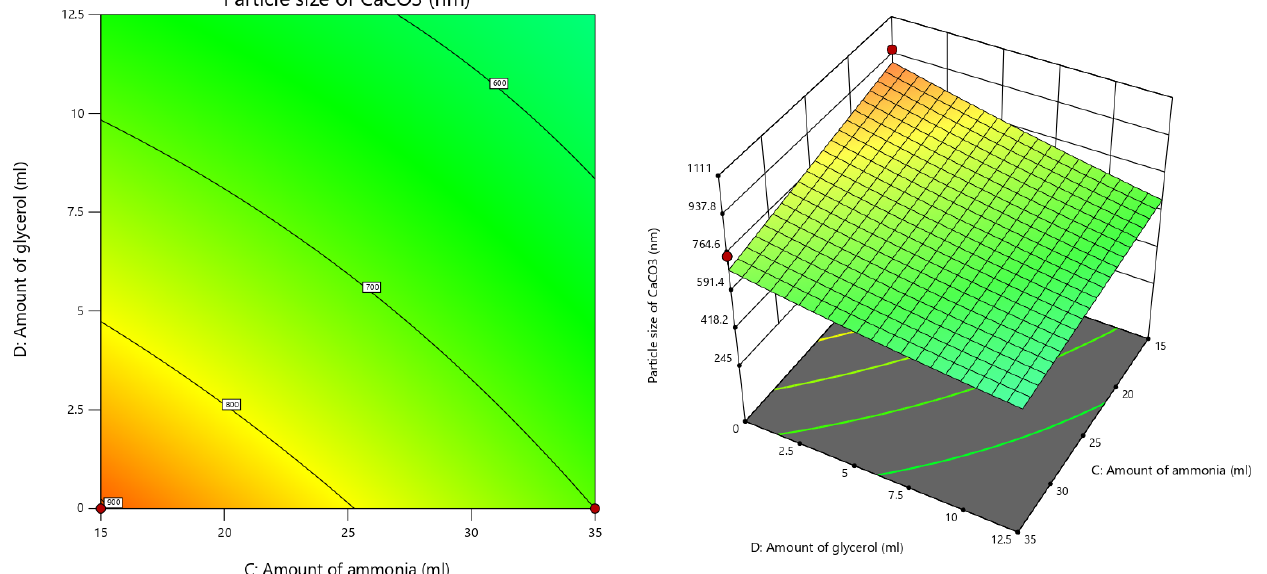
Figure 16. Relationship between the amount of ammonia, amount of glycerol, and the particle size of CaCO 3 (Contour and 3D plot).